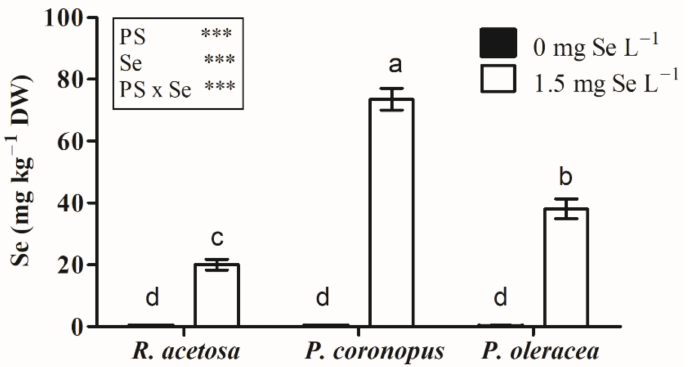
Figure 1. Se content (mg kg − 1 DW) in microgreens of various wild plant species grown indoors under controlled conditions with different concentrations of Se in the substrate. Bars indicated by the same letter are not statistically different for p = 0.05 after Duncan’s test. Significance level: *** p ≤ 0.001.